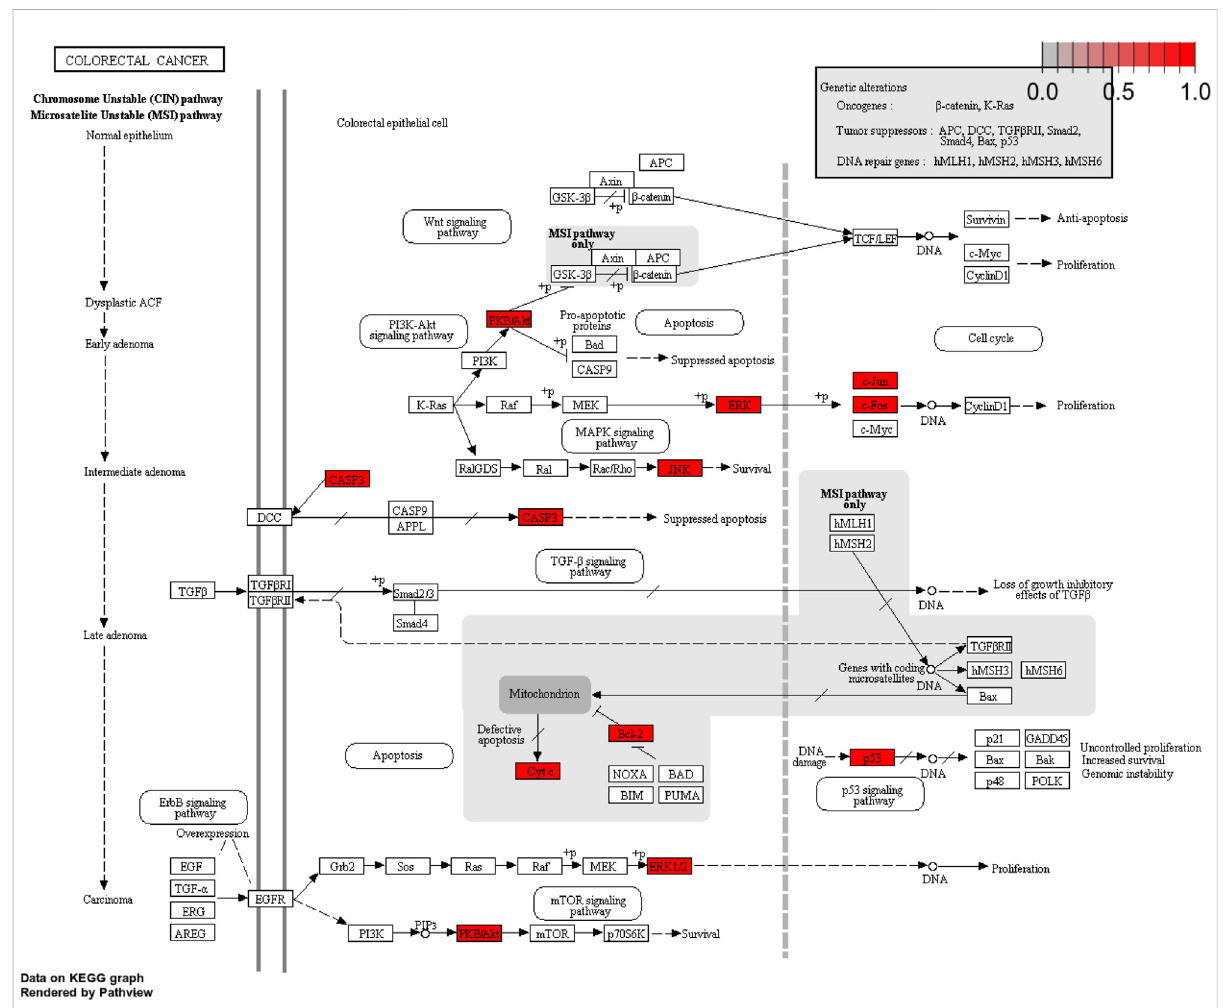
FIGURE 6 Colorectal cancer signaling pathway of YFBP potential target genes on CRC. The red represents YFBP target genes in the network.